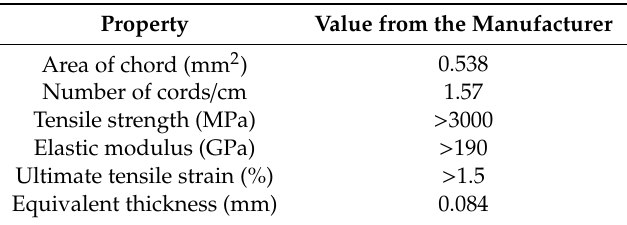
Table 1. Mechanical properties of steel fibers